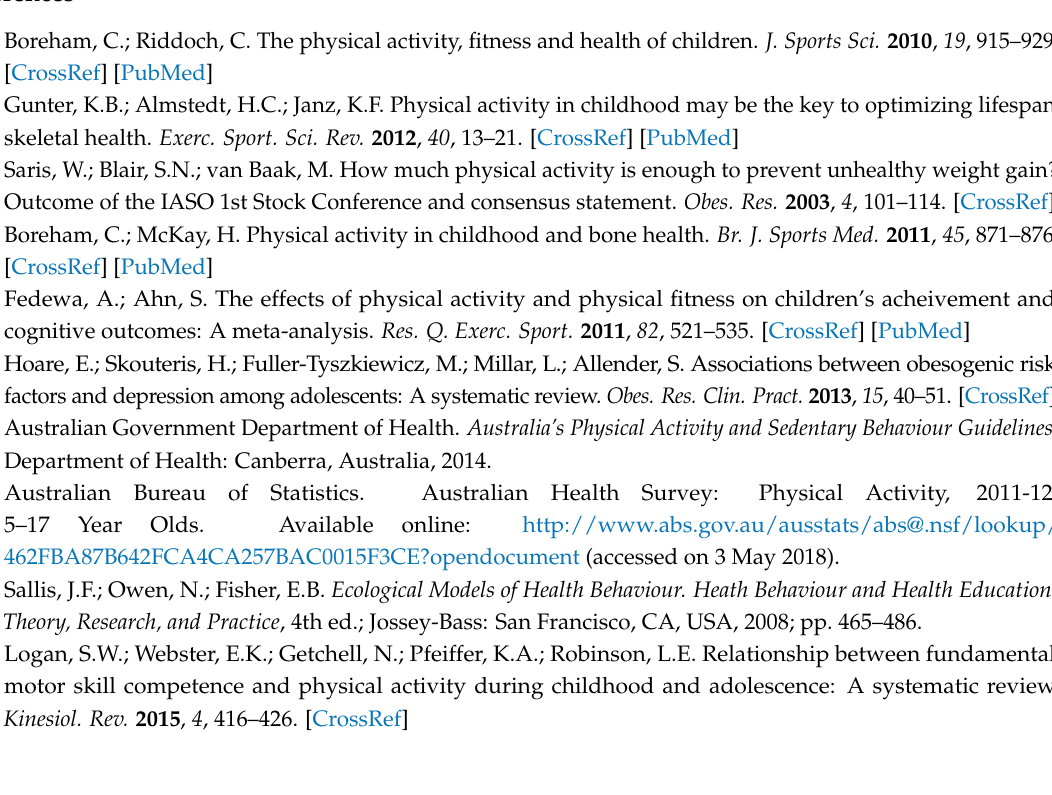
Table S1: Comparison of equipment between playgrounds, Figure S1: Images of playgrounds (a): Traditional playground; (b): Contemporary playground; (c): Adventure playground, Figure S2: Observation chart (Observation chart developed for the contemporary playground. For each scan, the corresponding FMS number was written in the box matching the piece of equipment the child was playing